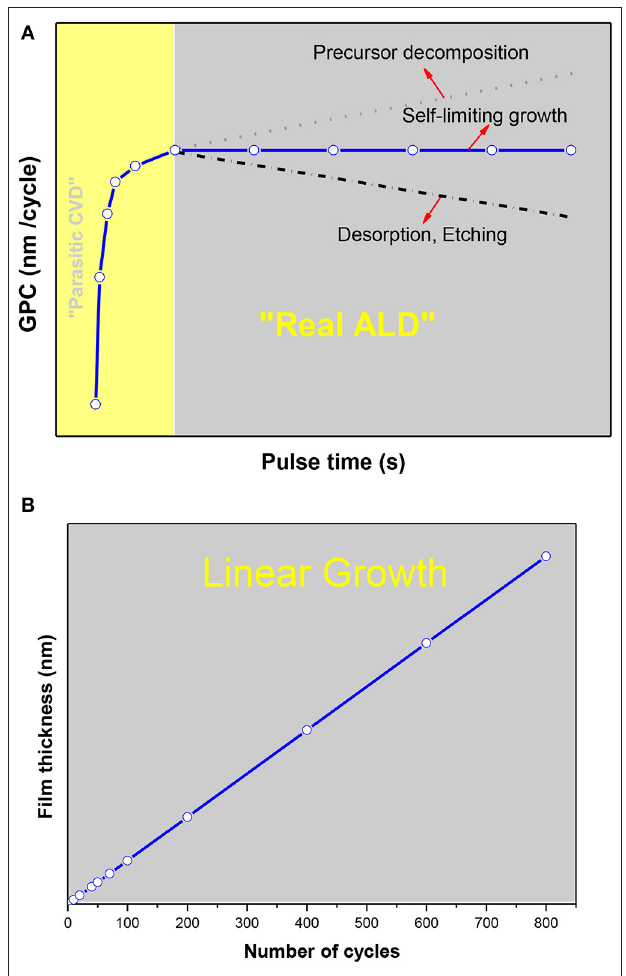
FIGURE 1 | Schematic diagram of the essential characteristics of the ALD: (A) saturation curve of GPC as a function of the pulse time of the reactants, and (B) film thickness growth linearly with the number of reaction